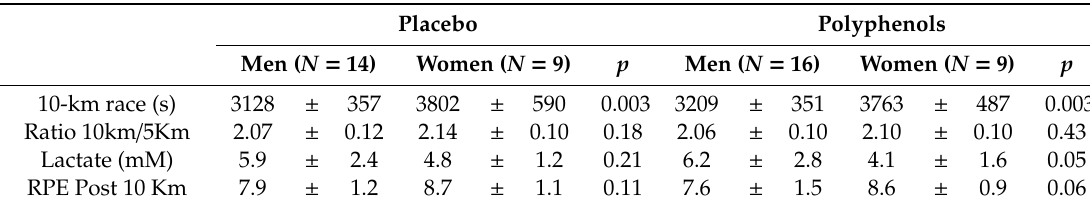
Table 4. Performance and pain after the 10 km race.